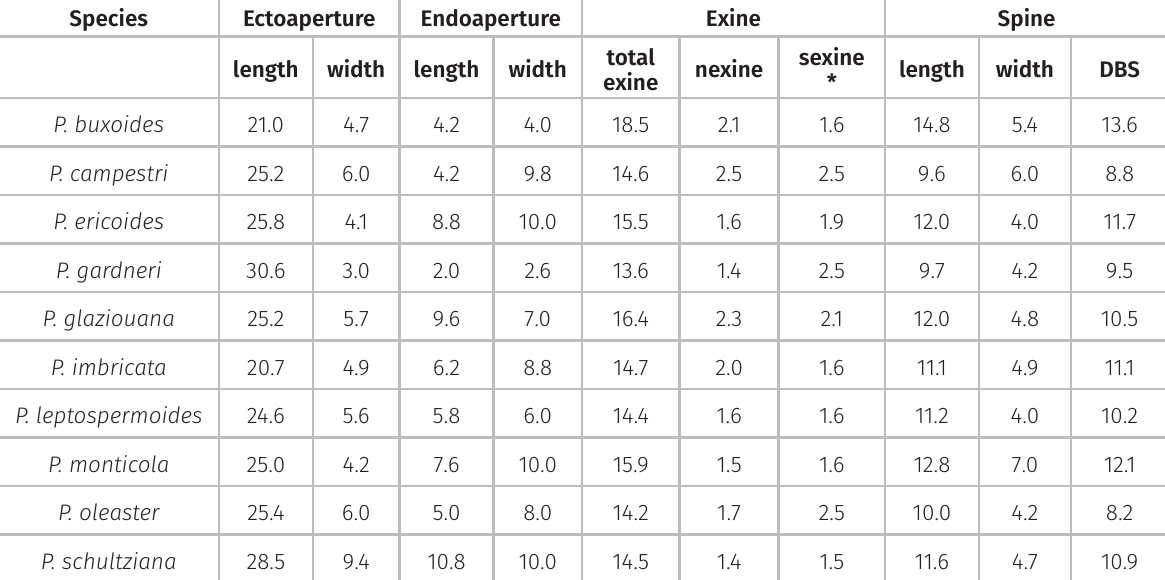
Table III. Measurements (in µm) of the apertures and layers of exine and spines of pollen grains of Piptolepis species (n=10). sexine* - tetum + columella. DBS - distance between the spines. Species